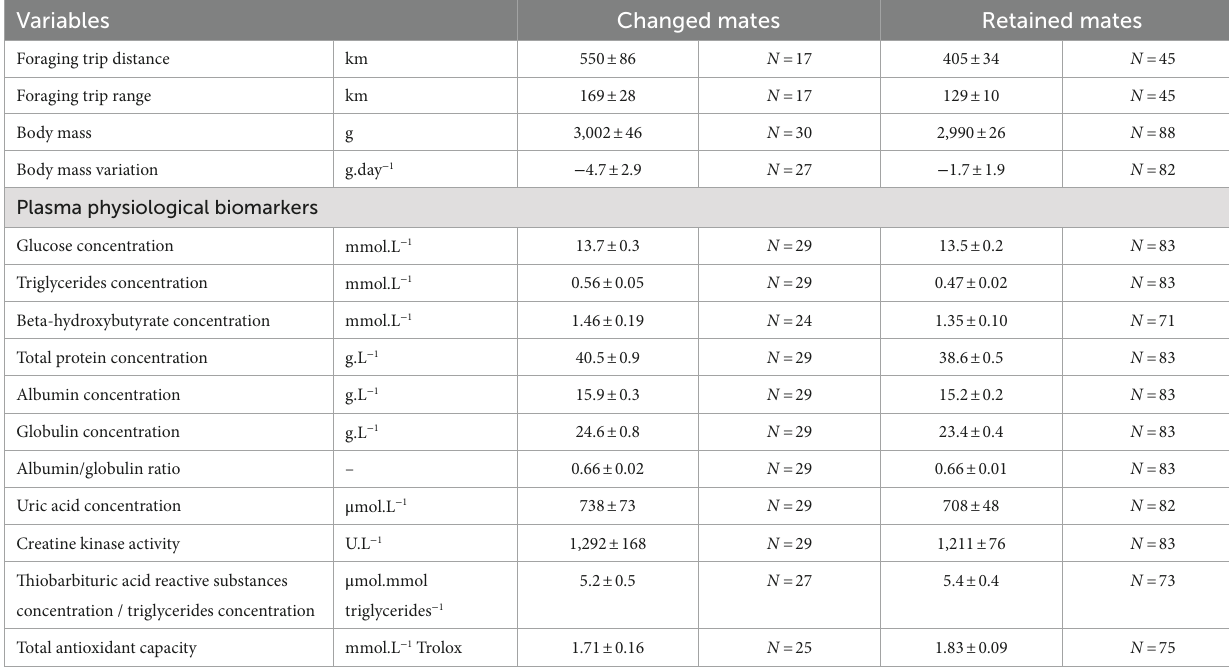
TABLE 1 Mean ± SEM of 15 behavioral and physiological biomarkers compared between northern gannets that changed or retained their mates in 2017, 2018 and 2019.